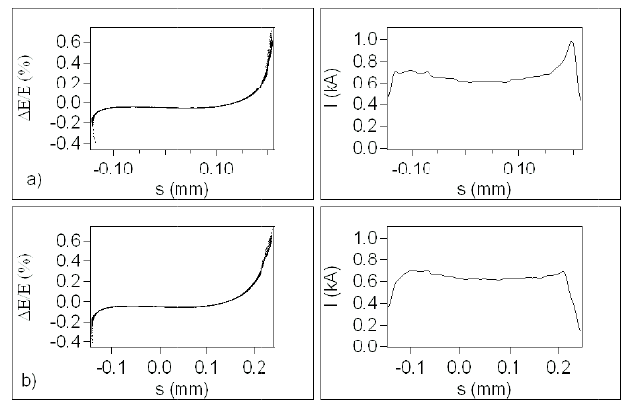
FIG. 8. The illustration for the removal of the spikes in the peak current at the electron bunch edges using adjustment in the R of ‘‘dog-leg’’ lattice: (a) R 56